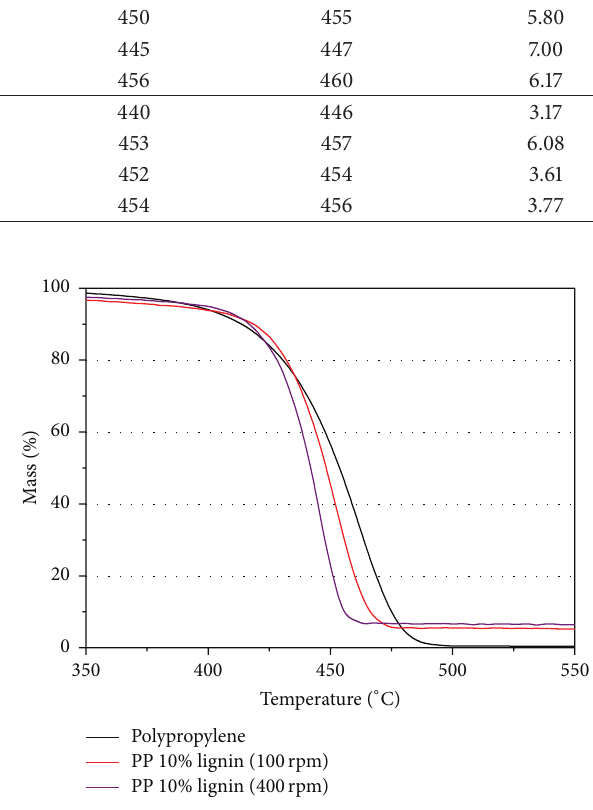
Figure 5: Thermal degradation curves versus temperature for pure PP and its blends with lignin and hybrid fillers, after extrusion with 400 rpm of screw speed.